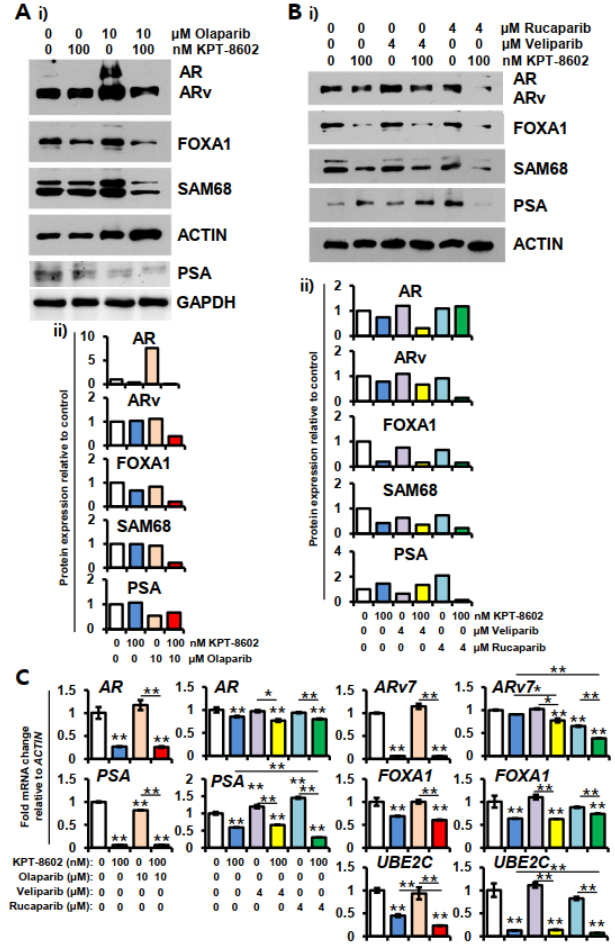
Figure 4. Expression of androgen receptor (AR) and its downstream target proteins and genes in 22rv1 cells treated with KPT-8602 and PARP inhibitors. Protein expression was determined by western blot analysis after 72 h of treatment and gene expression was determined after 24 h of treatment using real-time RT-qPCR. ( A ) Expression of AR, ARv, FOXA1, SAM68 and PSA in KPT-8602 and olaparib treated cells. ( B ) Expression of AR, ARv, FOXA1, PSA and SAM68 in KPT-8602 and veliparib- or rucaparib-treated cells. Lower panel shows relative protein expression obtained from band densities. NIH ImageJ 1.5Oi software was used to determine band density. ( C ) The mRNA expression of AR ; ARv7 , PSA , FOXA1 and UBE2C under specified treatment conditions. The color codes of designated treatment are consistent among the groups. All experiments have been done in triplicate and error bars represent standard deviation. * p < 0.05; ** p < 0.01.